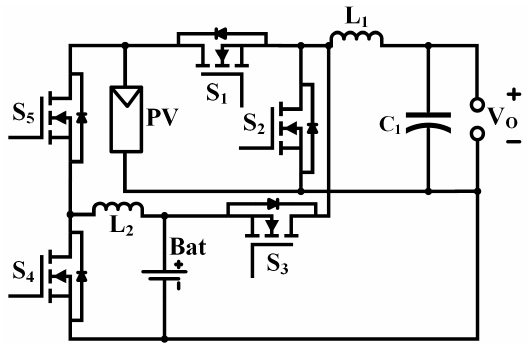
Figure 9. Type I-II-IA circuit